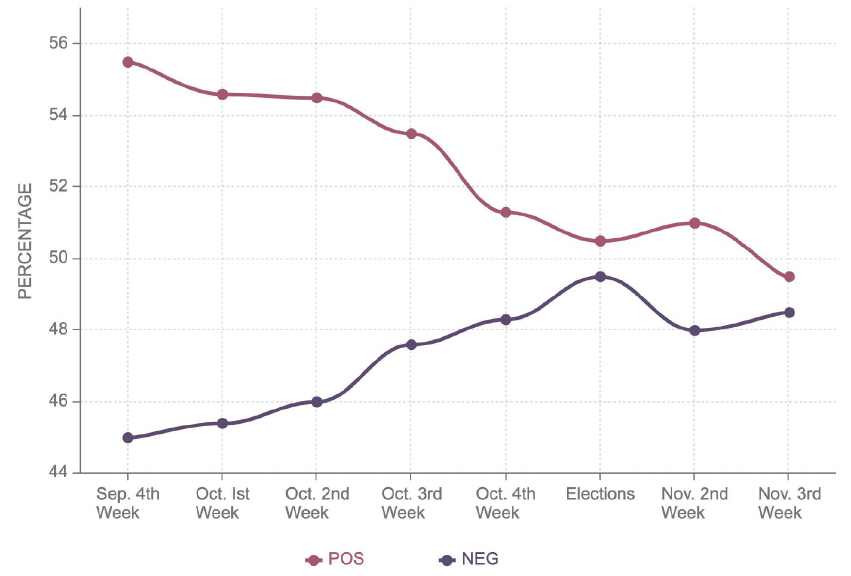
Figure 11. Graphs of positive and negative sentiments of Donald Trump in Pennsylvania.